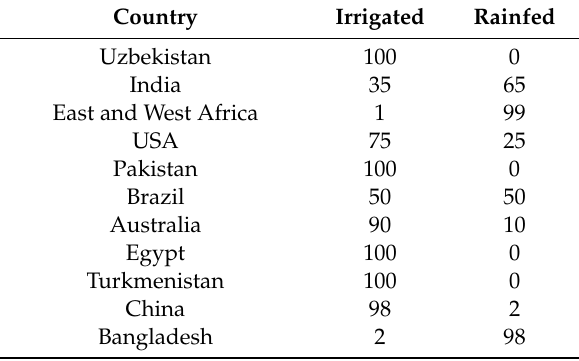
Table A8. Cotton cultivation condition (irrigated / rainfed) for di ff erent countries [79–89]. Country Irrigated